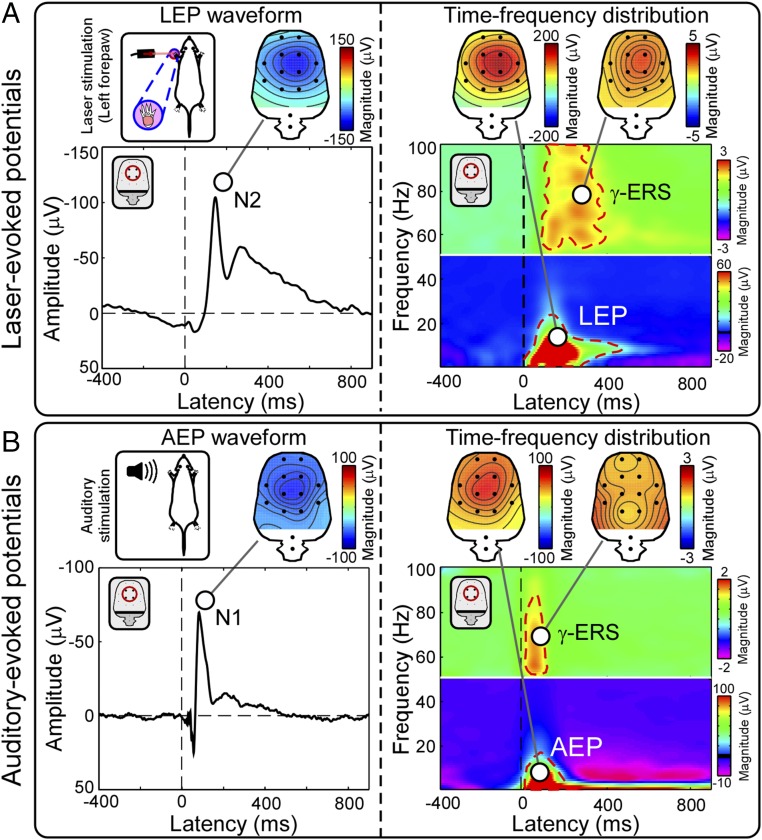
Experiment 3. Comparison of electrocortical responses elicited by nociceptive and auditory stimuli in rats. (A) Group-level brain responses elicited by nociceptive laser stimulation (exemplificative data from left forepaw). (B) Group-level brain responses elicited by auditory stimulation. In both sensory modalities, there was a clear negative deflection in the time domain (labeled N2 in the laser response and N1 in the auditory response), as well as clear phase-locked (LEP and AEP, black dashed lines) and non–phase-locked responses (γ-ERS, red dashed lines) in the time-frequency domain. The scalp topographies of the time-domain waves and of the time-frequency phase-locked responses were similar following nociceptive and auditory stimuli (always maximal at central electrodes). In contrast, scalp topography of γ-ERS was strikingly different: Whereas γ-ERS elicited by nociceptive stimuli was maximal at central electrodes and slightly contralateral to the stimulation site, γ-ERS elicited by auditory stimuli was maximal bilaterally, above the most lateral aspect of the parieto-temporal lobe.